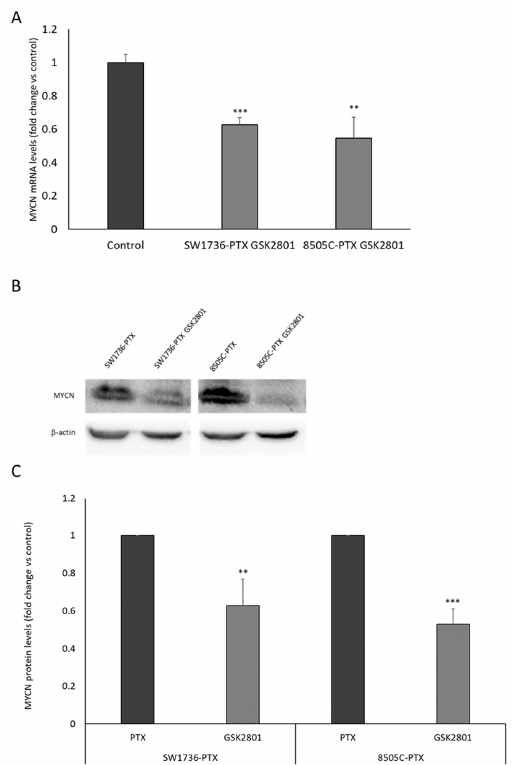
Figure 7. Effects of GSK2801 on MYCN RNA and protein levels. Panel ( A ): Relative expression levels of MYCN mRNA in SW1736-PTX and 8505C-PTX treated with GSK2801 20 µ M (SW1736-PTX GSK2801 and 8505C-PTX) or with DMSO only (control). All samples were run in triplicate. Control was arbitrarily set at 1.0. Panel ( B ) Western blot analysis of MYCN protein level in SW1736-PTX or 8505C-PTX treated with GSK2801 20 µ M (SW1736-PTX GSK2801 and 8505C-PTX GSK2801) or not (SW1736-PTX or 8505C-PTX). Panel ( C ): Densitometric analysis of MYCN protein levels in SW1736- PTX and 8505C-PTX cells treated with GSK2801 (GSK2801) or not (PTX). For each cell line, the results were normalized against β -actin levels and expressed in arbitrary unit. n = 3. ** p < 0.01, *** p <